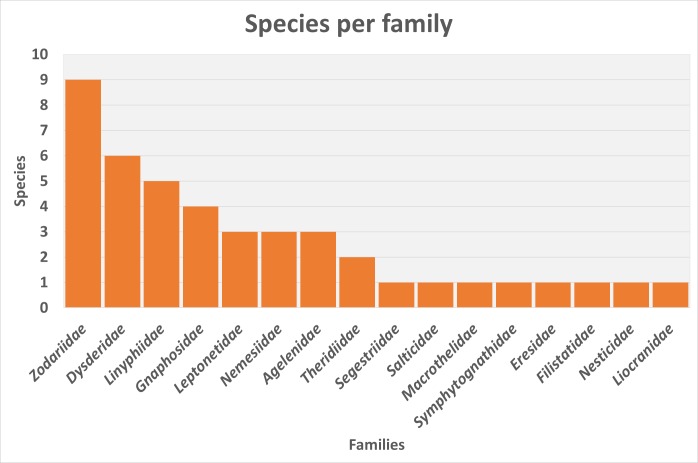
Number of assessed species per family.